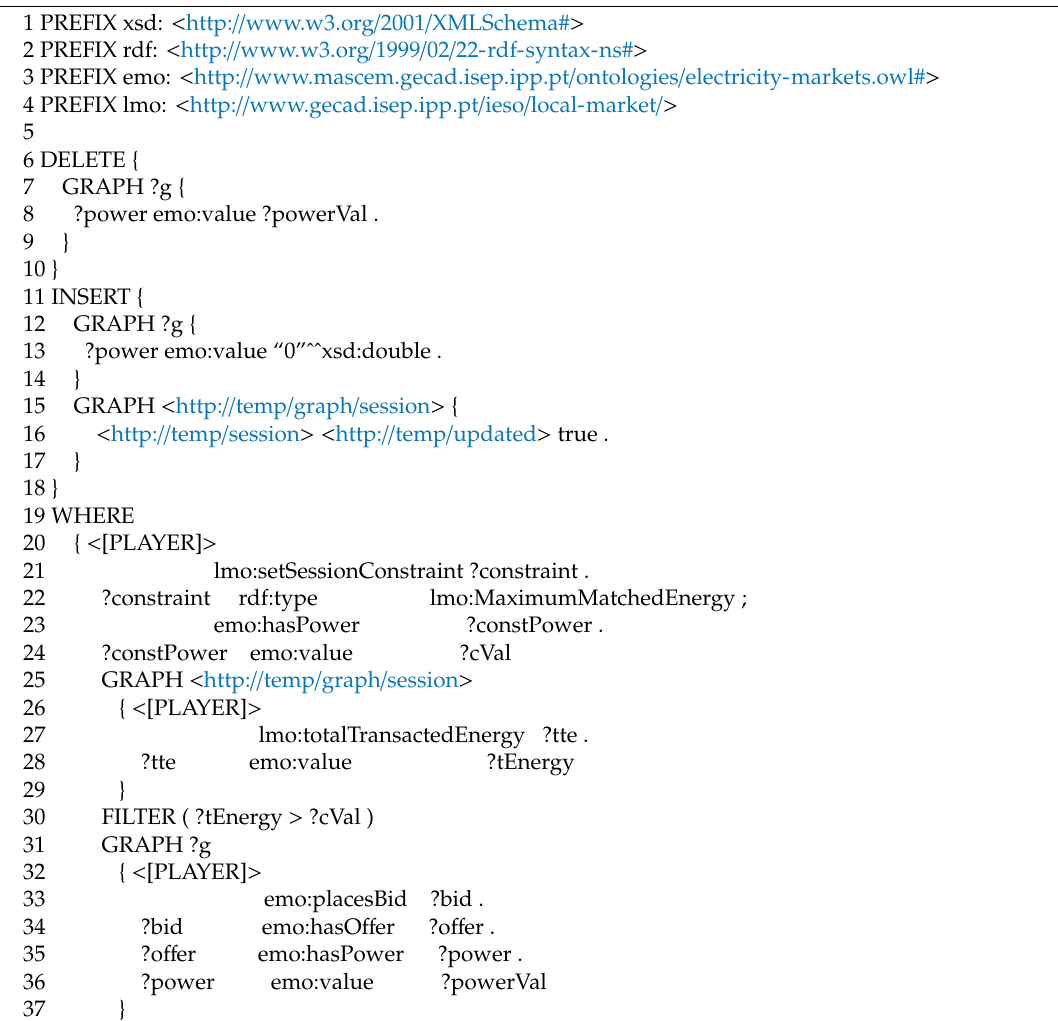
Listing 4. Session’s Maximum Matched Energy SPARQL